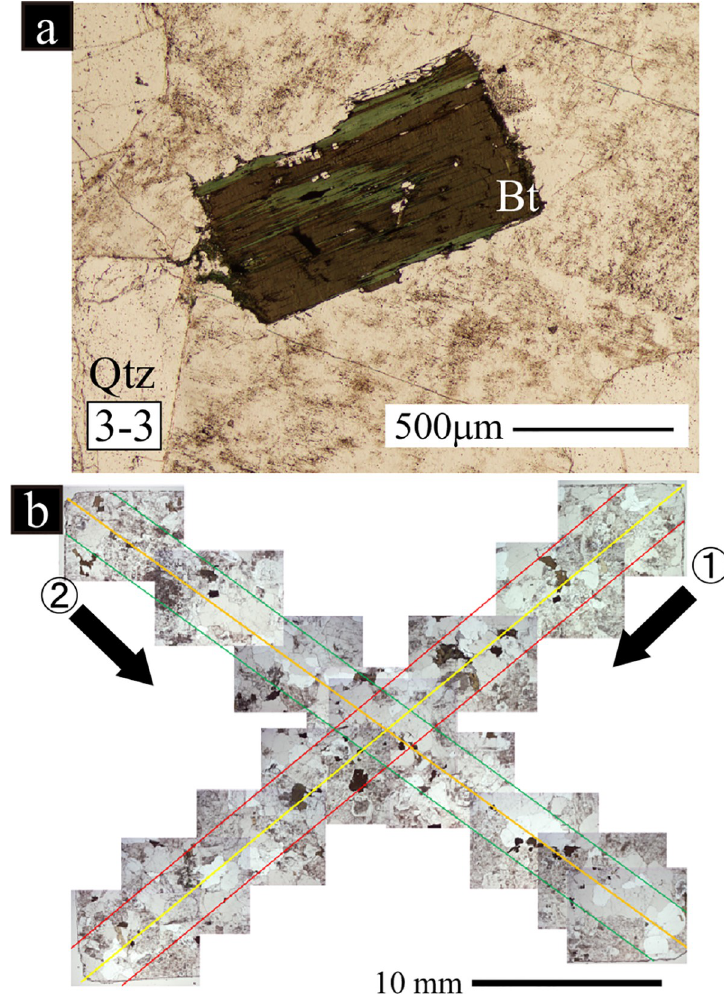
Fig 3. Polarizing microscope images of the biotite chloritization (a: sample No. 3–3) and an example of the thin section images used for the selection of target minerals (b). Two lines, the 1 st and 2 nd traverses, were established diagonally across a thin section. The traverses were 3.0 mm wide for biotite chloritization selections. The 1 st traverse for the biotite chloritization indicator selection is indicated by the area between the red lines and the 2 nd traverse is the area between the green lines. Bt: biotite; Qtz: